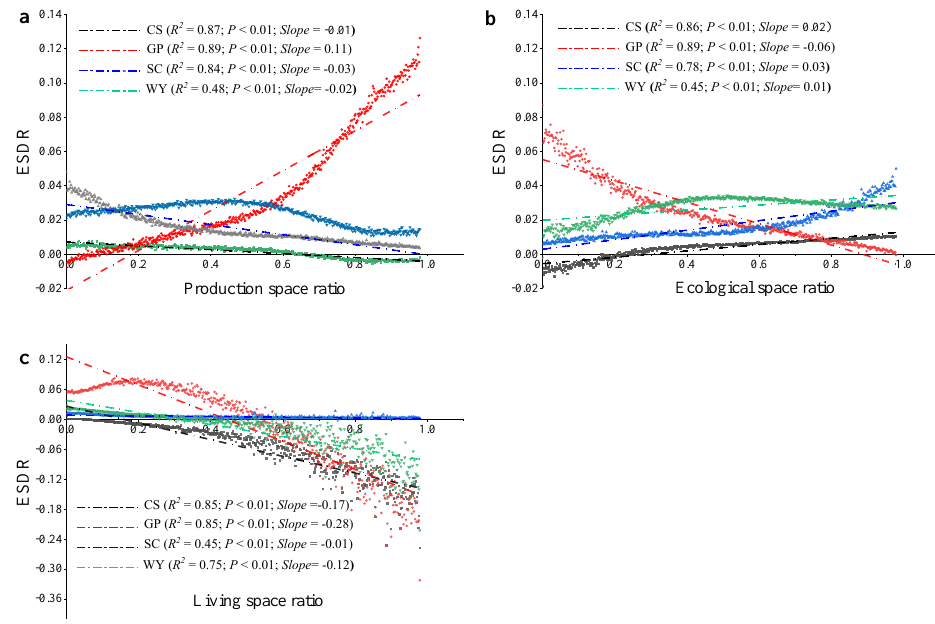
Figure 6. Influence of production space ratio, living space ratio, and ecological space ratio on ESDR in the Yellow River Basin. ( a ). Production space ratio ( b ). Ecological space ratio ( c ). Living space ratio.